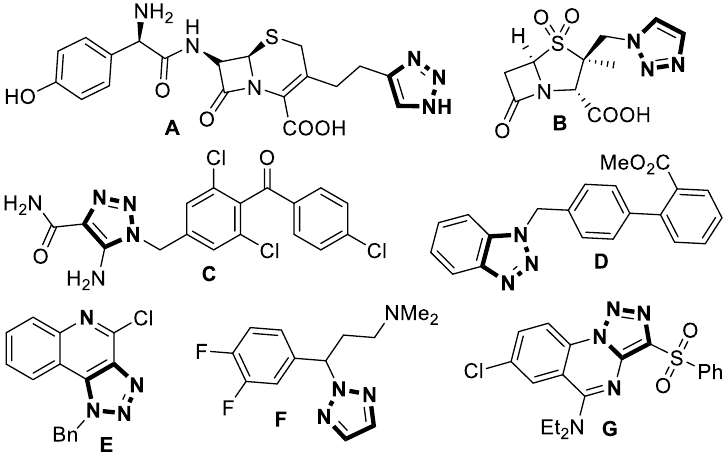
Figure 1. Some 1,2,3-triazole-based drugs and bioactive molecules.